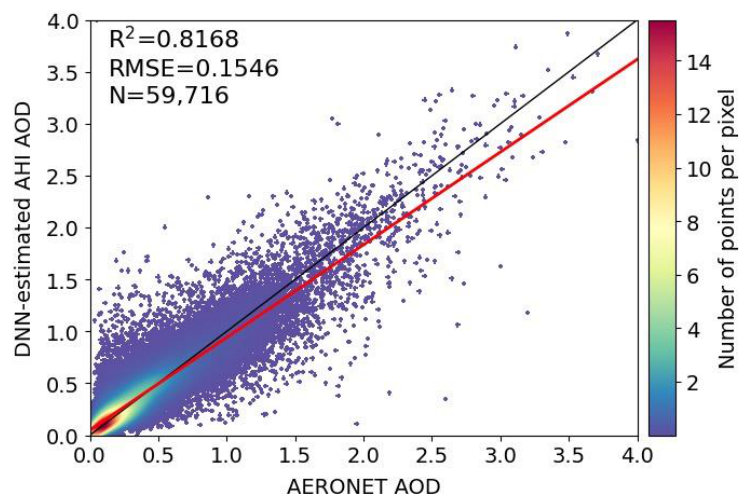
Figure 5. Comparison between DNN-estimated AHIAOD and AERONET AOD.